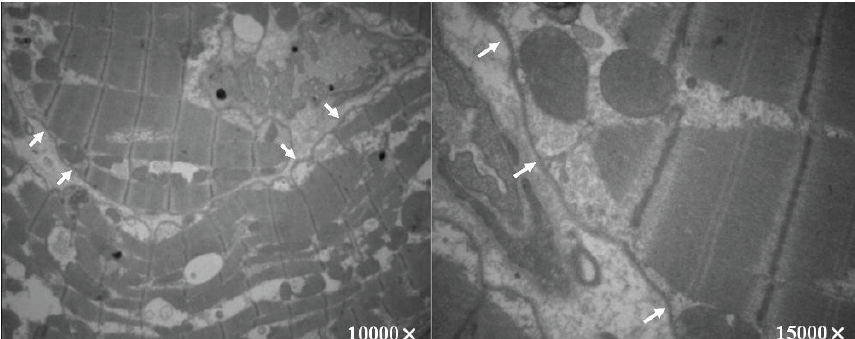
Figure 5. Electron micrographs of heart muscles of defibrillated dogs. Note that the cell membrane is intact [white arrow].